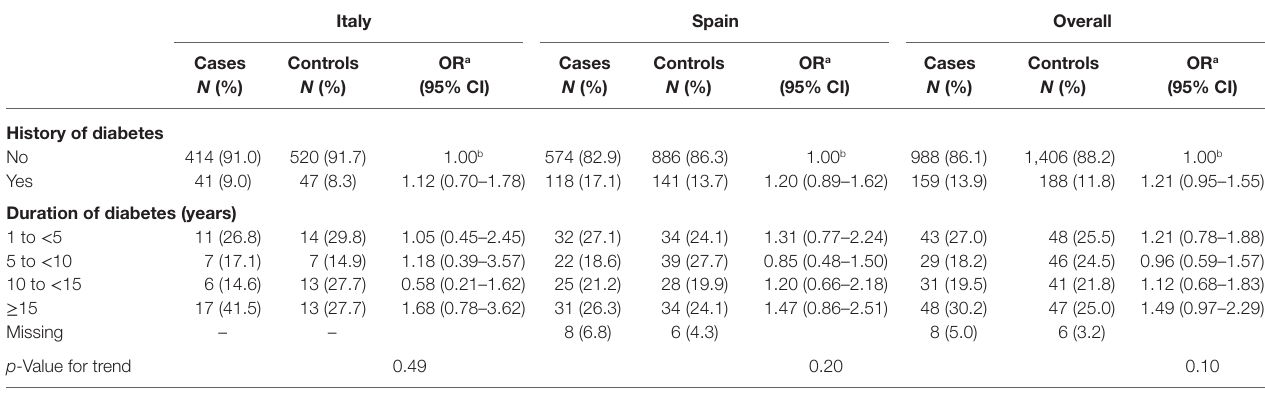
TaBle 2 | Distribution of 1,147 colorectal cancer cases and corresponding 1,594 controls, with odds ratios (Ors) and 95% confidence intervals (cis), according to history of diabetes by country and overall. italy